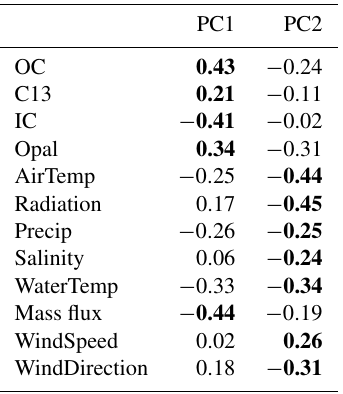
Table 2. Coefficients in the linear combinations of variables making up PCs. The higher coefficients for each PC are shown in bold